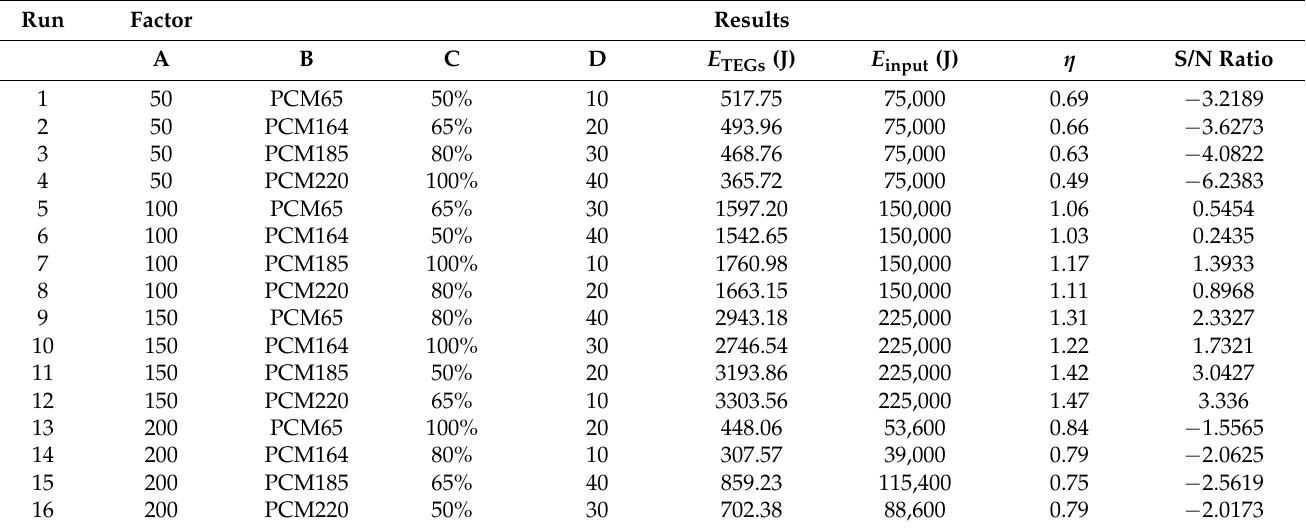
Table 4. The results of the numerical simulation in L16 orthogonal array.